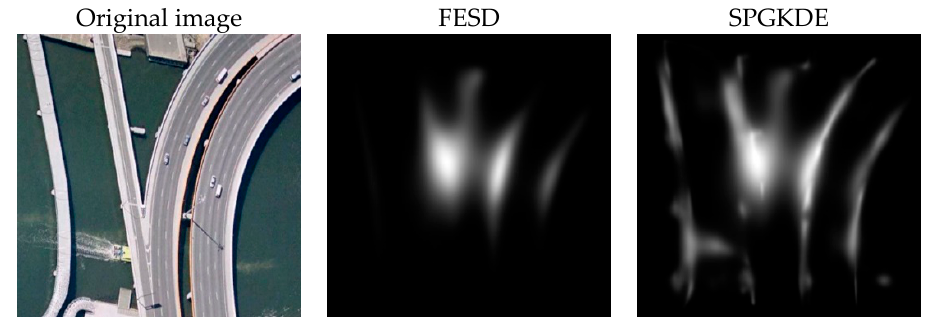
Figure 2. Saliency maps comparison between FESD (fast and efficient saliency detection method, which is proposed by reference [13]) and SPGKDE (spatial pyramid Gaussian kernel density estimation). In this paper, a spatial pyramid Gaussian kernel density estimation (SPGKDE) saliency detection